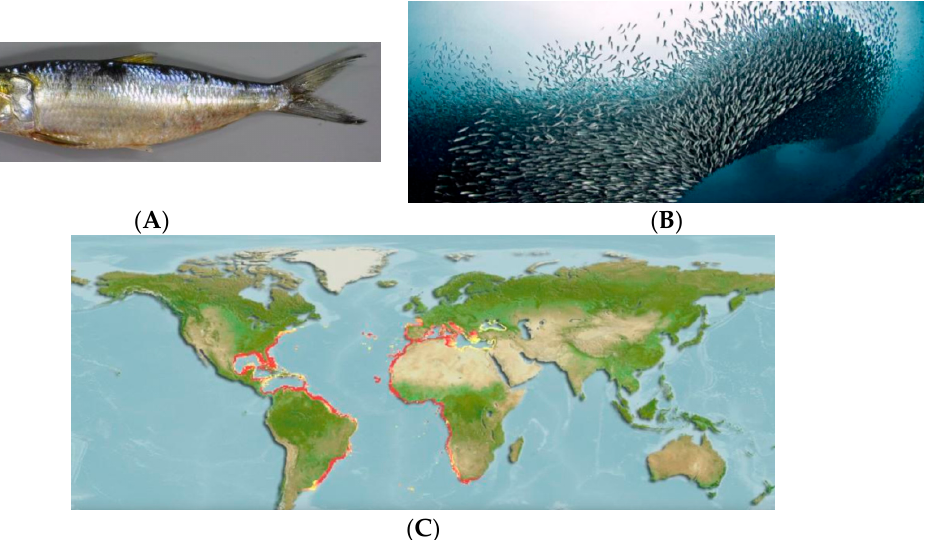
Figure 1. The global distribution of Sardinella aurita ; red zones represent locations of high occurrence and yellow zones represent locations of low occurrence. ( A ) Image for a school of Sardines . ( B ) The species: Sardinella aurita . ( C ) The global distribution of Sardinella aurita .